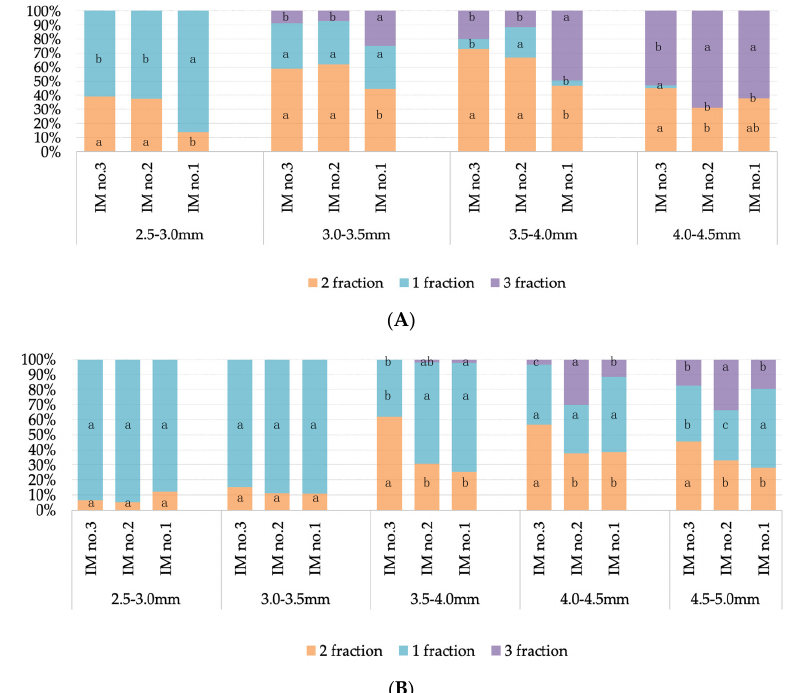
Figure 3. ( A ) Ratio of different fractions of microspores in a population of spring rapeseed ‘Ratnik’ microspores according to bud size and method of isolation: 1 fraction—very early developmental stages; 2 fraction—optimal developmental stages for embryogenesis induction; 3 fraction—late de ‐ velopmental stages. IM—isolation method. Diagram ranges with the same letter ( с comparison of the fraction percentage in the population of microspores within the same fraction (same color) and the same bud size) are not significantly different with 95% probability according to the Duncan multiple range test (MRT). Data from two ‐ way analysis of variance (ANOVA) and the contribution of the influence of factors are presented in Table S2. ( B ) Ratio of different fractions of microspores in the European radish ‘RBK’ microspore population according to bud size and method of isolation: 1 fraction—very early developmental stages; 2 fraction—optimum developmental stages for embry ‐ ogenesis induction; 3 fraction—late developmental stages. IM—isolation method. Diagram ranges with the same letter ( с omparison of the fraction percentage in the population of microspores within the same fraction (same color) and the same bud size) are not significantly different with 95% prob ‐ ability according to the Duncan multiple range test (MRT). Data from two ‐ way analysis of variance (ANOVA) and the contribution of the influence of factors are presented in Table S2. Thus, the relative concentration of microspores of the second fraction in spring rape ‐ seed ‘Ratnik’ reached a maximum at bud size of 3.5–4.0 mm and was 73% for isolation method № 3, 66.7% for isolation method № 2 and 46.7% for isolation method № 1. In gen ‐ eral, in spring rape the concentrations of the second fraction were significantly higher in bud sizes 3.0–4.0 mm in all variants of the experiment, but the percentage of the second fraction was significantly lower in isolation method № 1 than in other variants. Thus, for spring rape the worst isolation method is method No. 1. In addition, in contrast to the method of isolation No. 3 in the variant of experiments with isolation No. 1 and No. 2 in the size of buds 4.0–4.5 mm, the concentration of the second fraction microspores did not exceed 40%, which, together with the level of debris may be a decisive factor in the effec ‐ tiveness of IMC